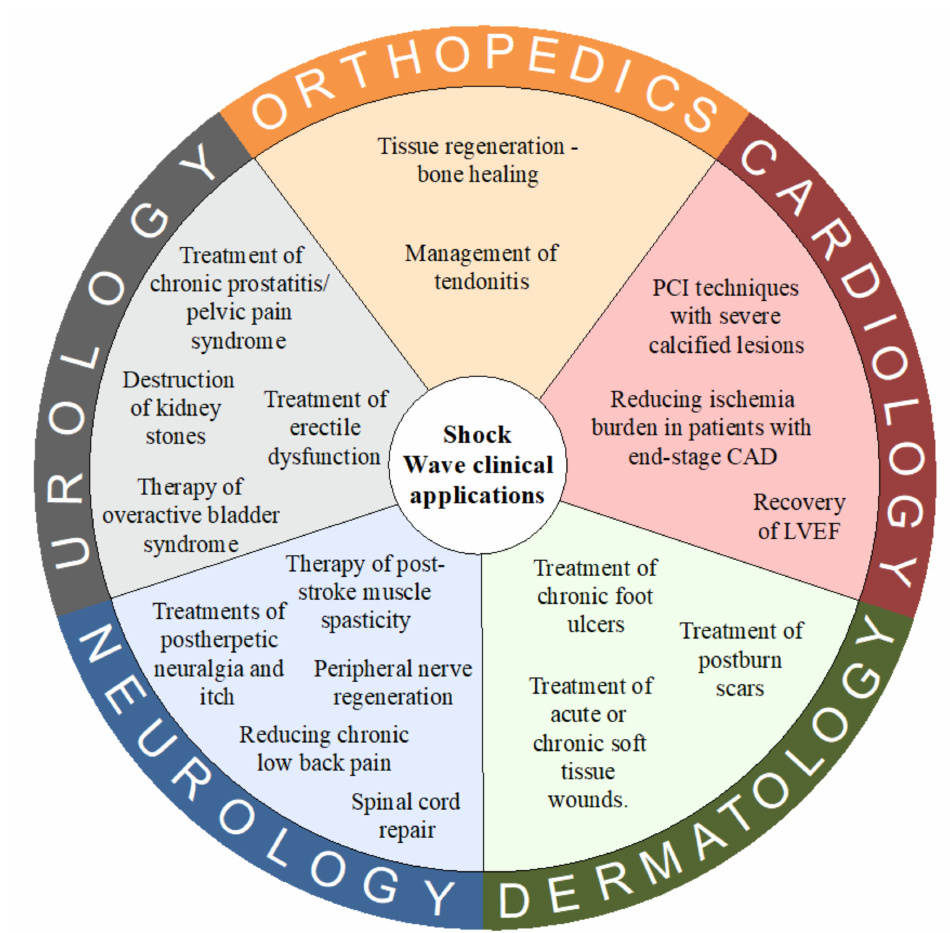
Figure 2. Basic clinical applications of Shock Wave Therapy. Abbreviations: CAD = coronary artery diseases; LVEF = left ventricle ejection